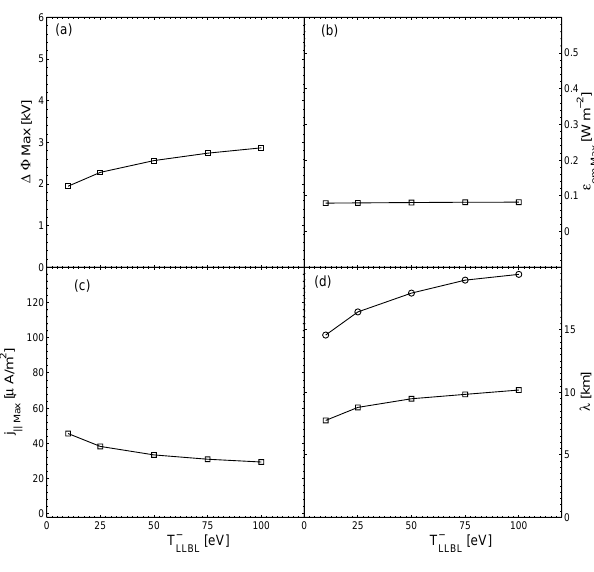
Fig. 9. Variation of arc characteristics as a function of the tem- perature at the LLBL side of the TD. See caption of Fig. 5 for a description of